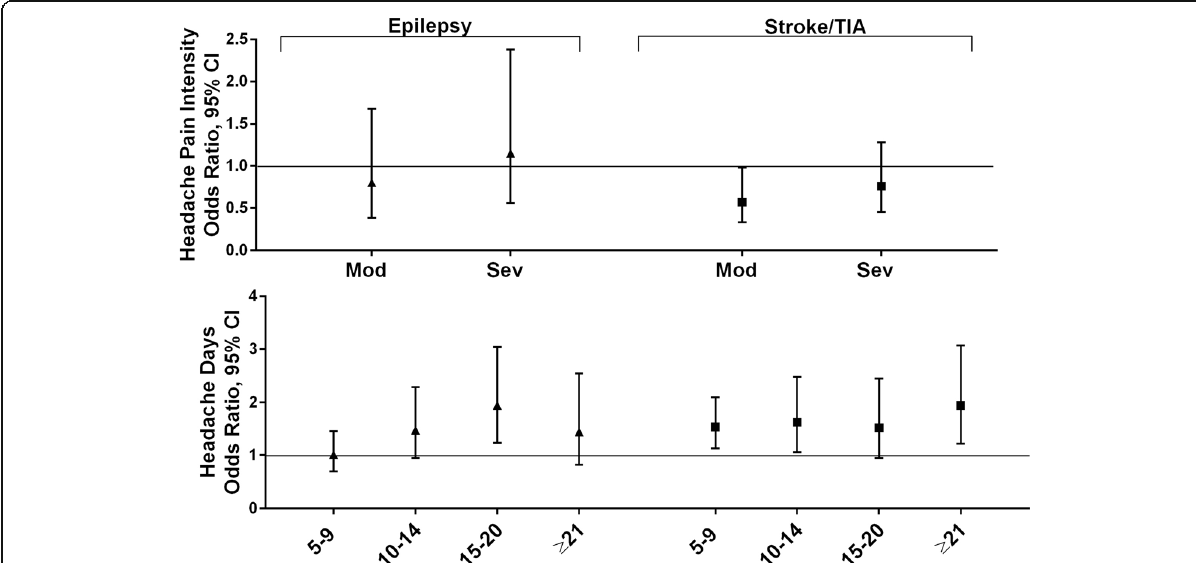
Fig. 3 Among persons with migraine the odds ratios (and 95% CI) for each comorbid neurologic condition*. *Fully adjusted models with sociodemographic characteristics (age, gender, Hispanic origin, race, marital status, employment, household income), headache pain intensity and